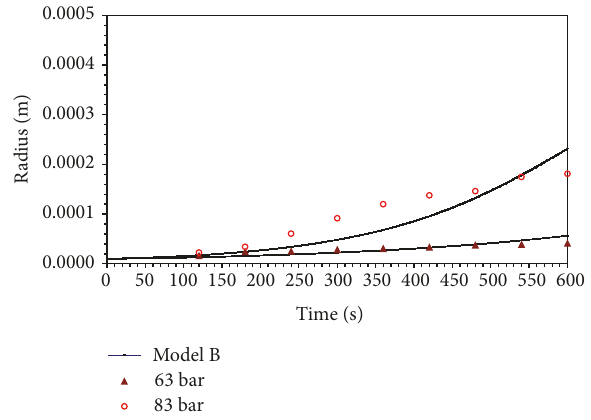
Figure 19: Model C versus experimental data for bubble growth at 70 ∘